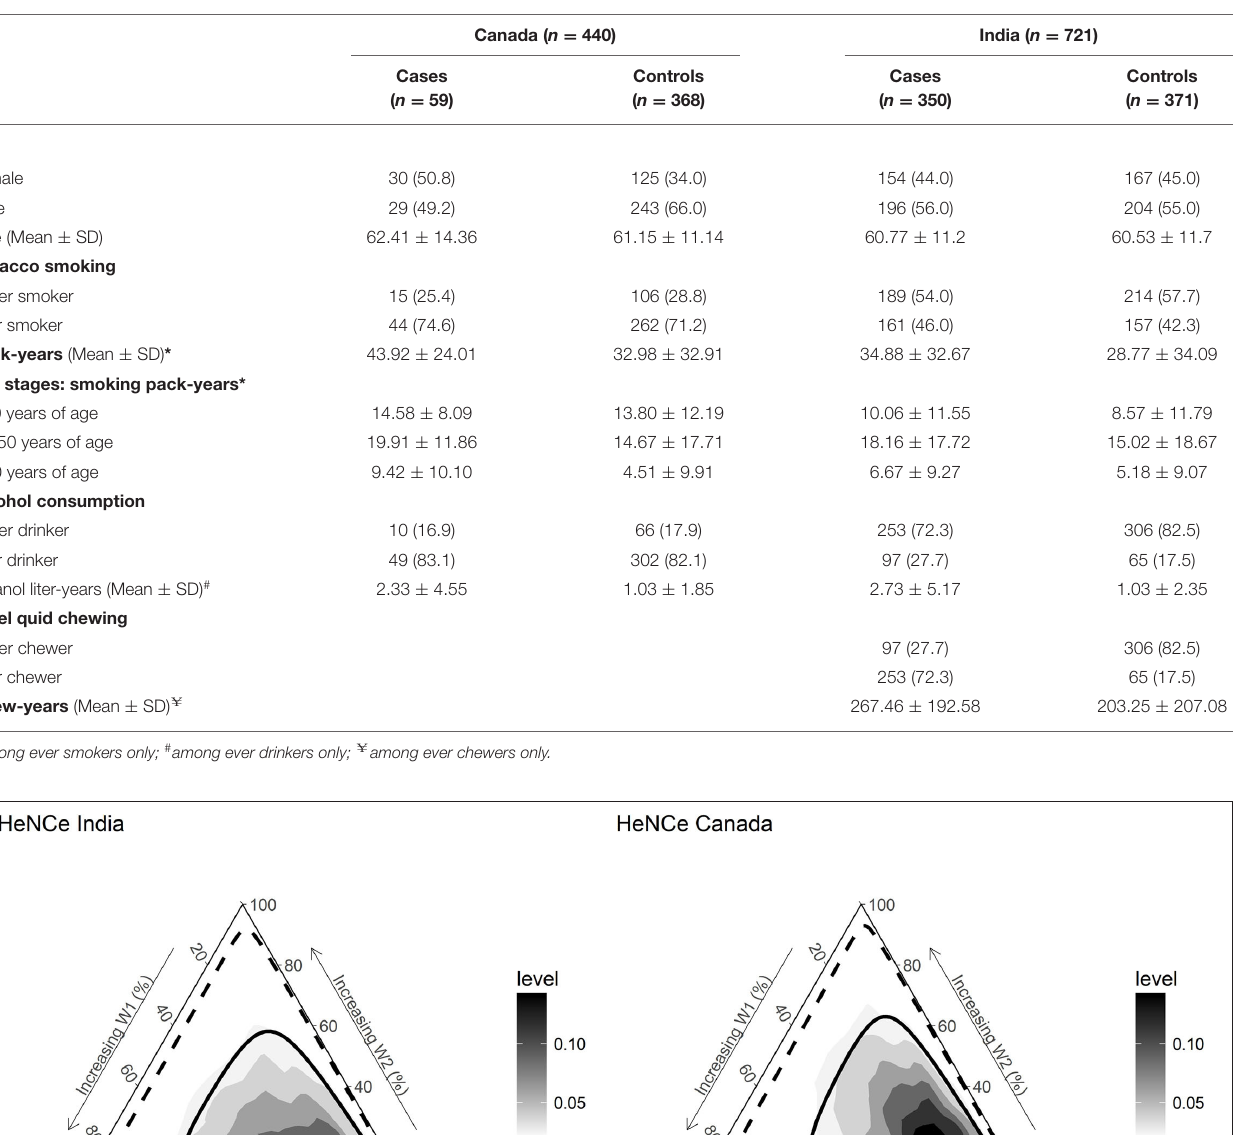
TABLE 1 | The distribution of selected socio-demographic and behavioral risk factors among human papillomavirus negative (HPV − negative ) oral cavity cancer cases and controls in the HeNCe Life study: Canada and India sites.